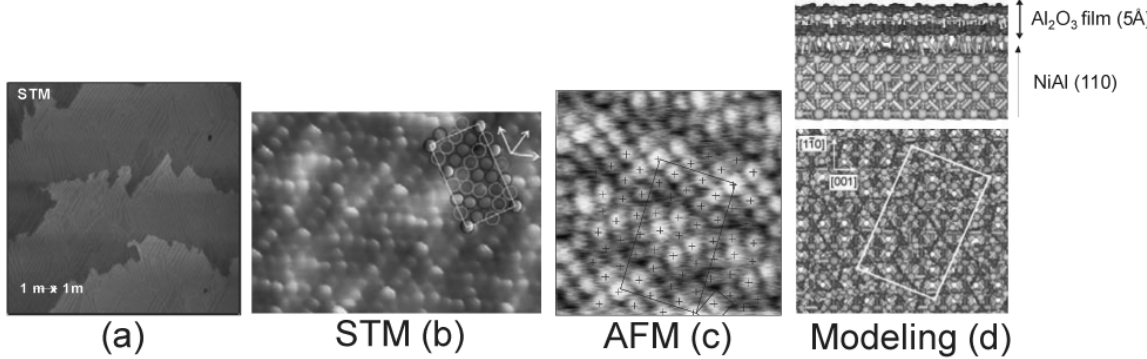
Fig. 7 – STM and AFM images of alumina on NiAl(110): (a) large scale STM image showing the antiphase domain boundaries, (b) atomic resolution STM, (c) atomic resolution AFM, (d) alumina as modeled with DFT typ and side view (Kresse et al. 2005, Kulawik et al. 2006, Simon et al. 2008).